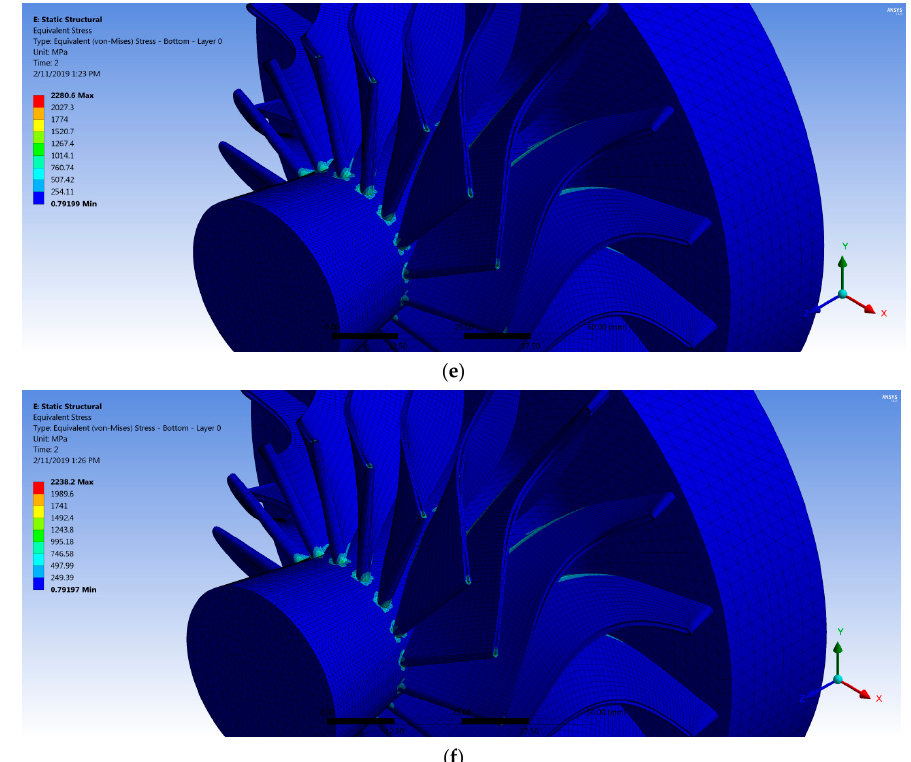
Figure 17. von Mises stress for the turbine with ( a ) Steel rotor blades and ( b – f ) a composite rotor with different fiber orientations: ( b ) 20°; ( c ) 30°; ( d ) 40°; ( e ) 50°; and ( f ) 60°.